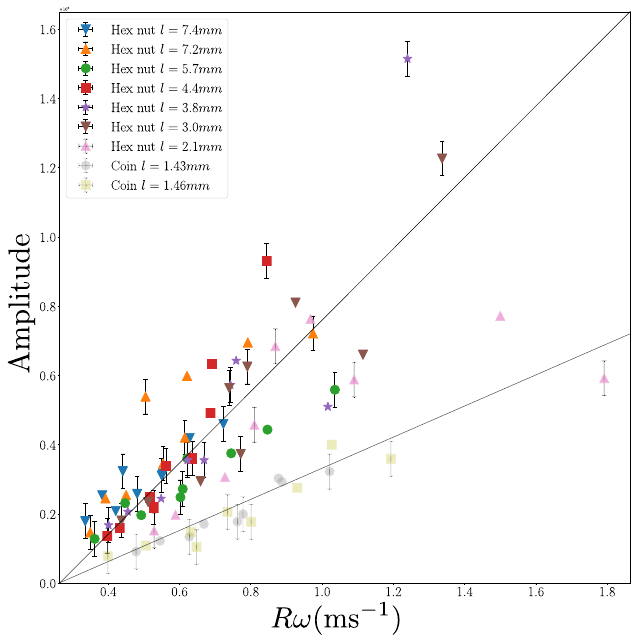
Fig. 9. The amplitude A plotted as a function of Rω for the same type of nuts, same rotation speeds and same balloon radii as above. Linear regressions are plotted for each type of nuts. Coin data points are plotted with low opacity due to deviation from the regression coefficient of the hex